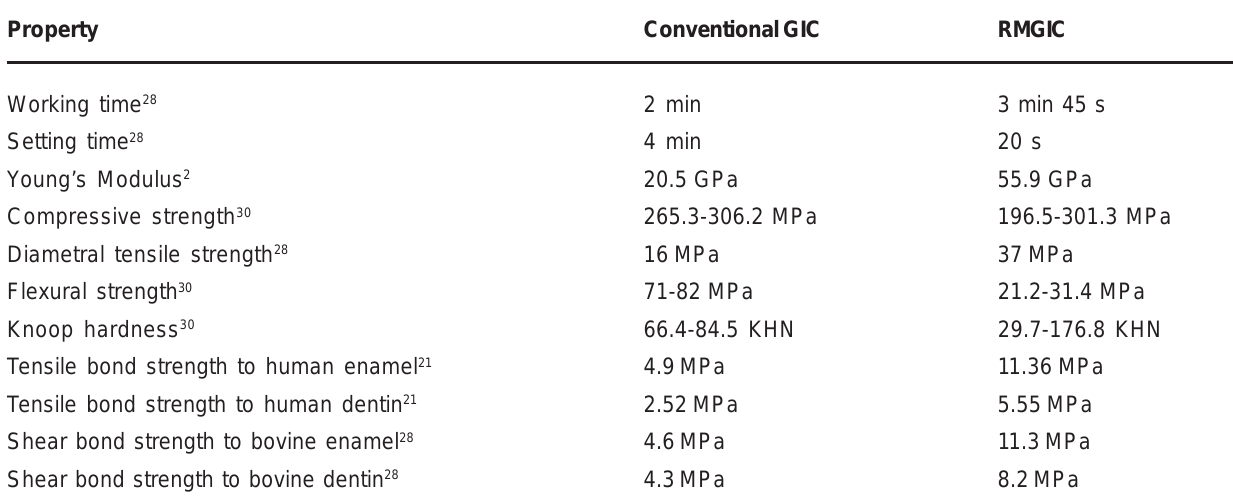
TABLE 1- Literature-based data on representative properties of GIC and RMGIC